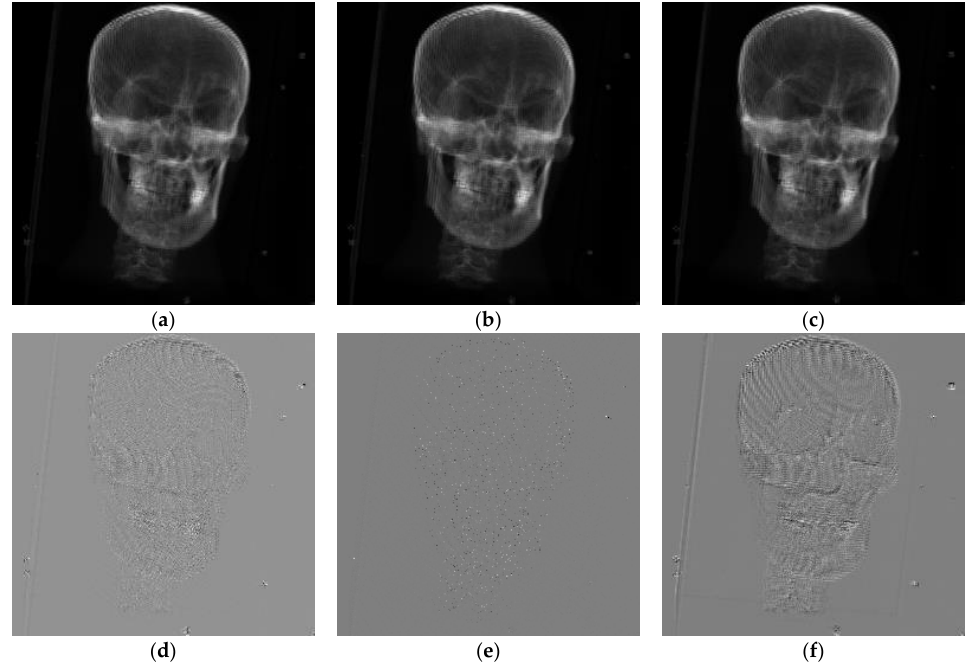
Figure 9. Experimental results of group 3. ( a ) DRR based on NCCS registration; ( b ) DRR based on NCCL registration; ( c ) DRR after registration based on NCC; ( d ) difference map after registration based on NCCS; ( e ) difference map after registration based on NCCL; ( f ) difference map after registration based on